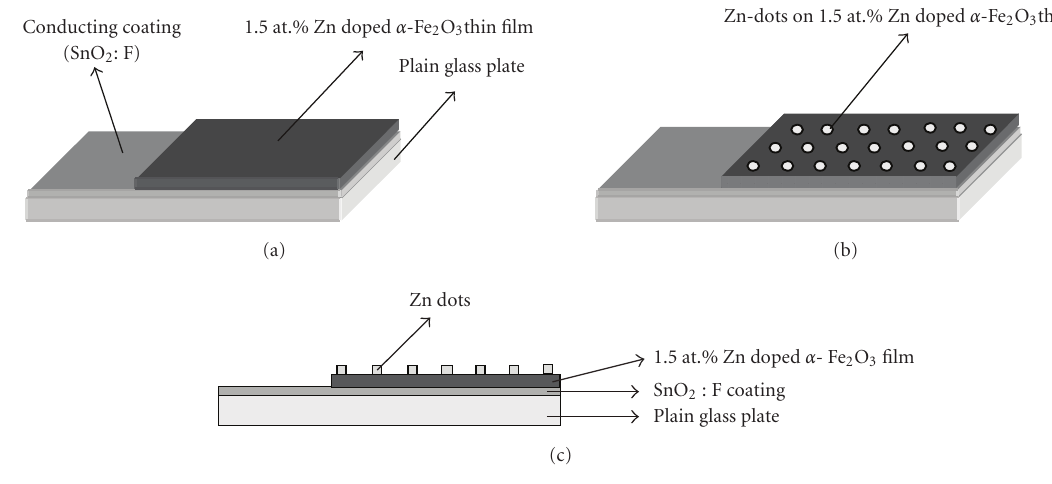
Figure 1: Schematic diagram of Zn-dotted islands on 1.5 at.% Zn-doped α -Fe 2 O 3 thin